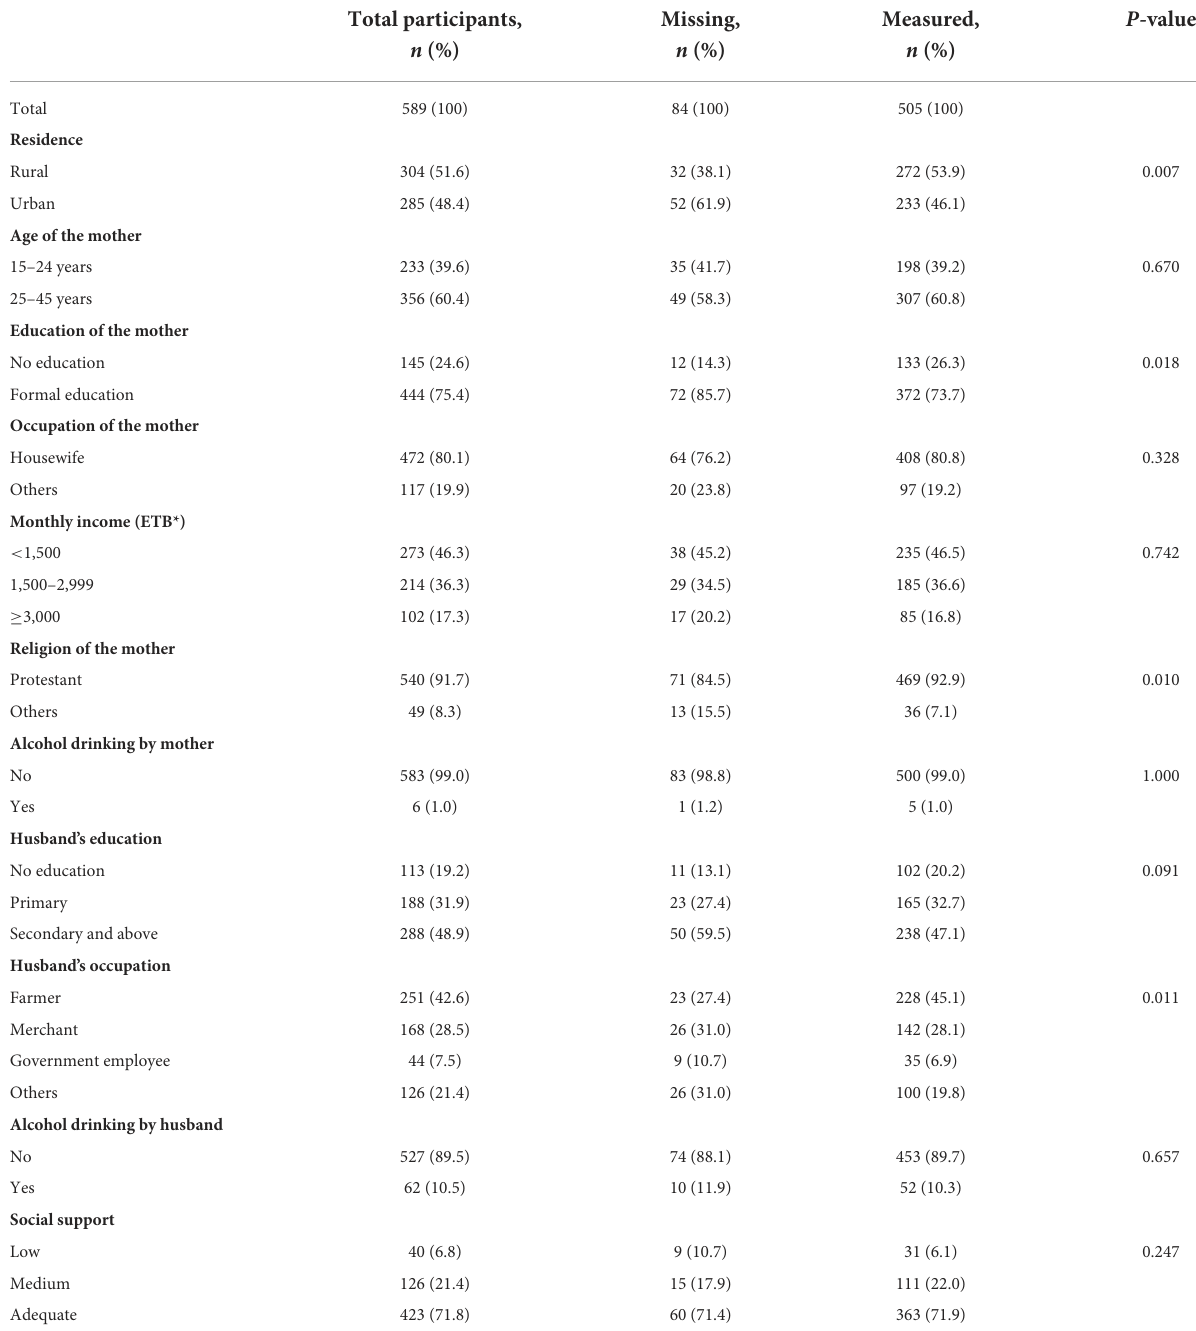
TABLE 1A Socio-demographic characteristics of pregnant women enrolled in the study whose baby’s birth weight was measured or not, in Wondo Genet district, Ethiopia, 2017.